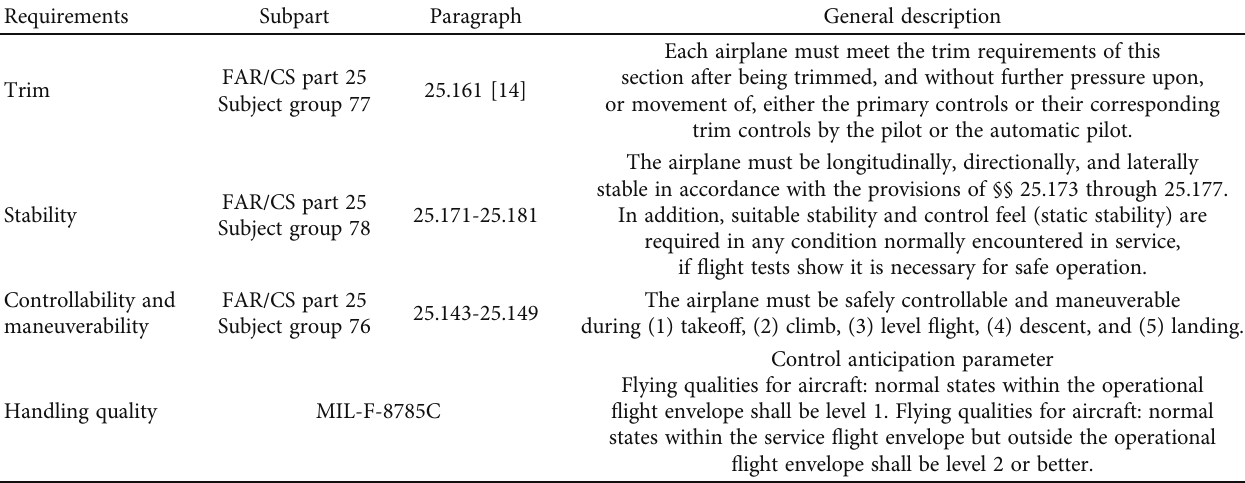
Table 1: Tail design requirements from regulations.